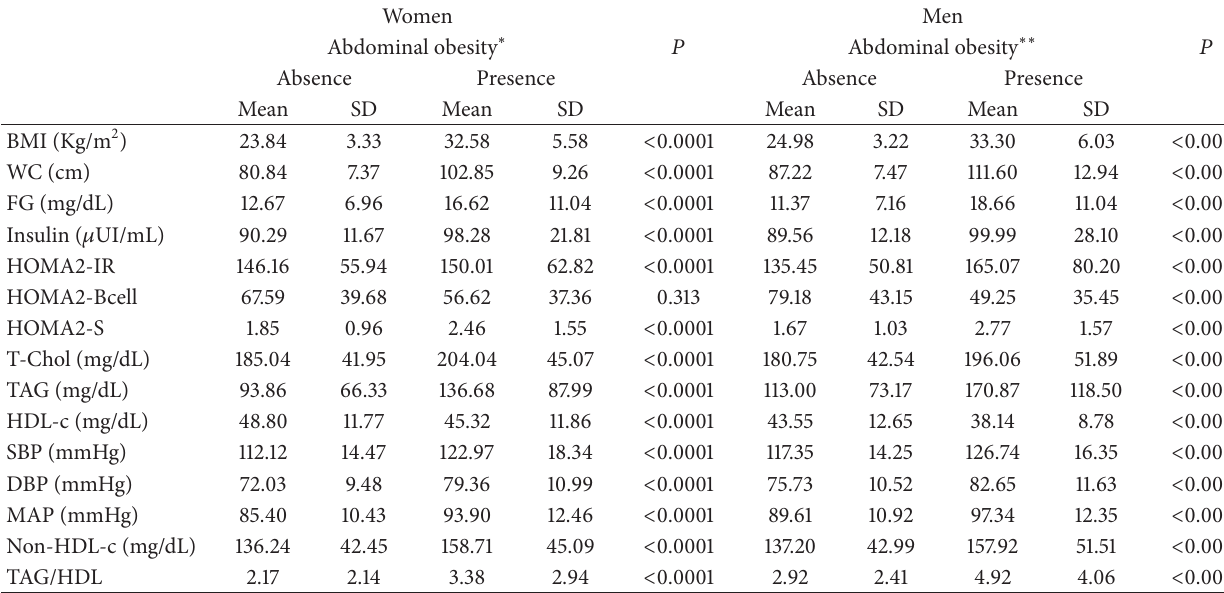
Table 8: General characteristics of the subjects after categorization using the newly selected WC cutpoints. Maracaibo City Metabolic Syndrome Prevalence Study,